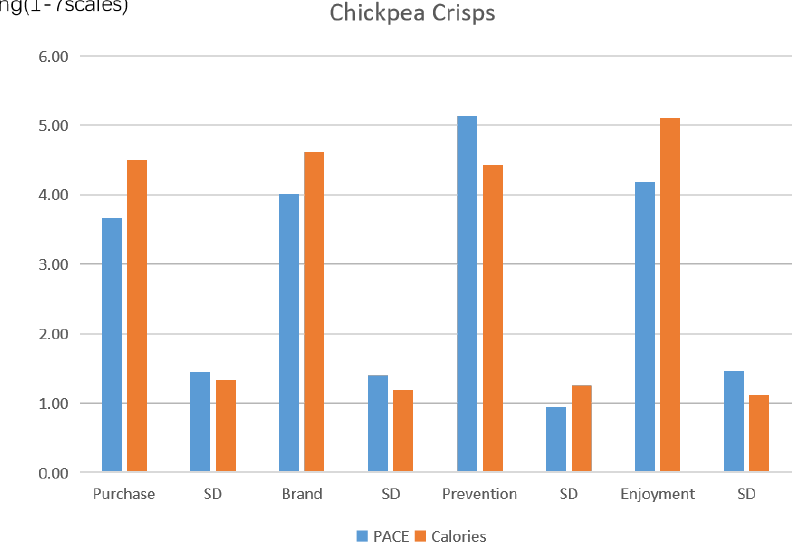
Figure 4. The effect of labels on purchase intention, food brand evaluation, prevention focus and anticipated anticipated enjoyment.